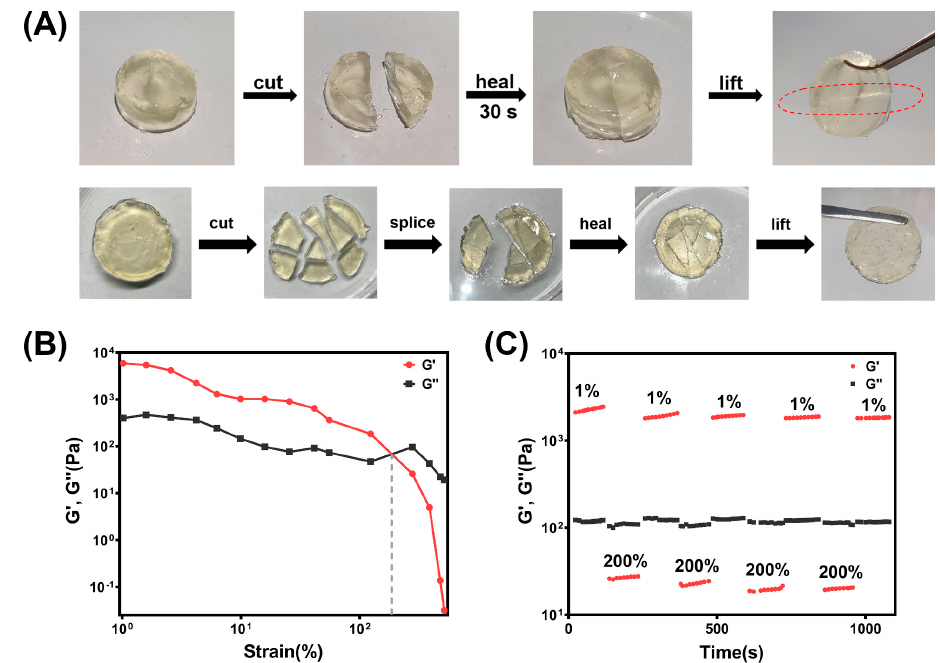
Figure 4. Self-healing abilities of the QAF hydrogels. ( A ) Macroscopic self-healing tests; ( B ) Strain amplitude sweep measurements ( γ = 1%–500%); ( C ) Alternate step strain sweep measurements with small strain ( γ = 1%) to large strain ( γ = 200%) with 120 s for every interval.